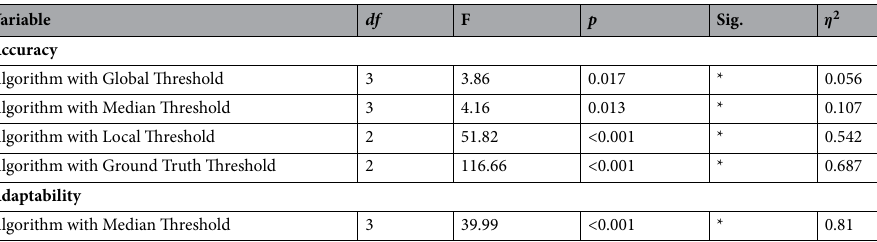
Table 2. Summary of the ANOVAs’ results. Df = Degrees of Freedom in the numerator, F = F-value, p = probability of the data given the null hypothesis, Sig. = p-values less than the traditional α <0.05, η Generalized Eta-Squared measure of effect size.